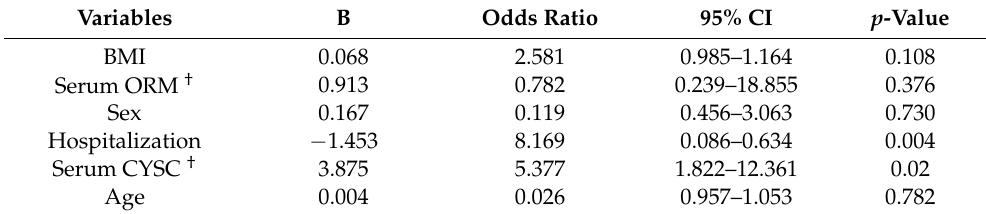
Table 5. Binary logistic regression analysis assessing correlations between anti-SARS-CoV-2 spike antibody (S-Ig) level and demographic/clinical variables. In this model we assigned a binary dependent variable to serum S-Ig level based on the median value of the sample (0: ≤ median, 1: >median).